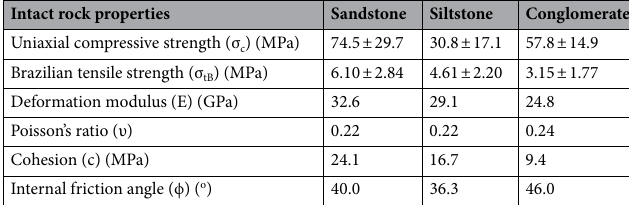
Table 1. Intact rock properties of frequently encountered rock formations.